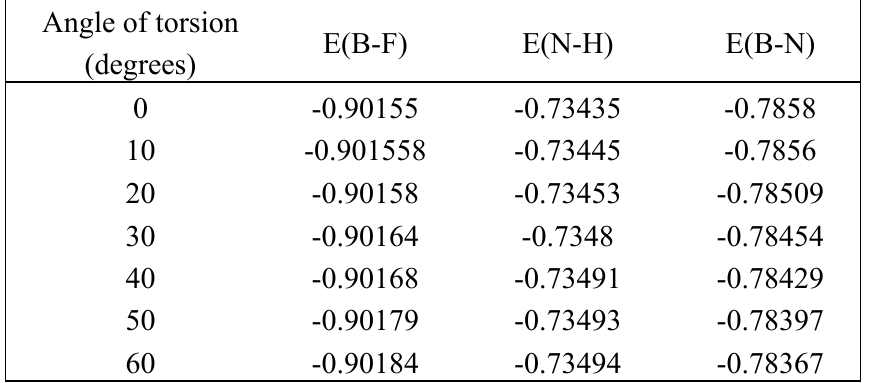
Table 7. Two-center bonded interaction energy (a.u.) as a function of torsional